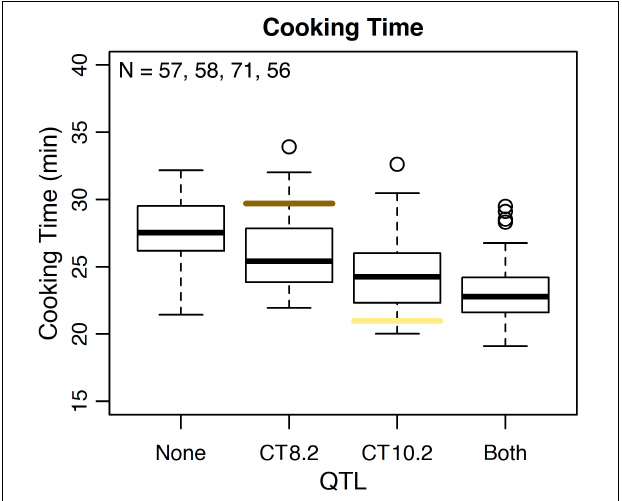
FIGURE 9 | Phenotypic effect of CT8.2 and CT10.2 in the RIL population based on the peak SNP alleles and average cooking time across both years. Cooking times for RILs with no fast-cooking alleles (none), the fast-cooking CT8.2 allele (CT8.2), the fast-cooking CT10.2 allele (CT10.2), and both fast-cooking alleles (both) are displayed in boxplots. Means for Ervilha and PI527538 from both years combined are indicated in yellow and brown,